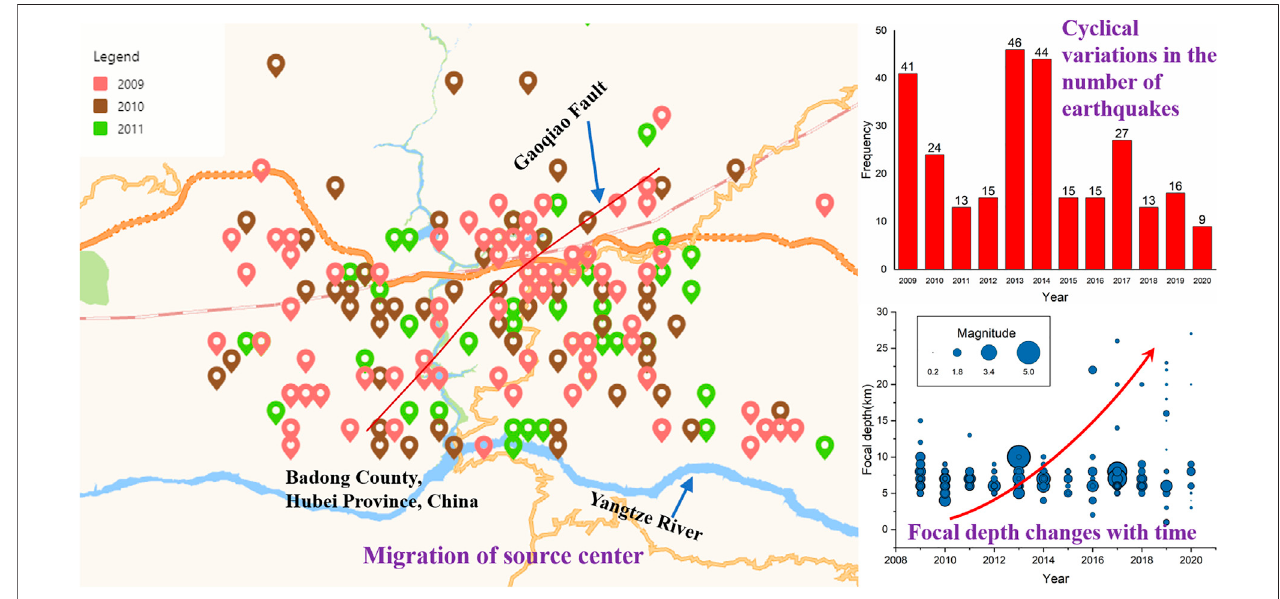
FIGURE 1 | Seismic law of Badong Reservoir in the Three Gorges Reservoir area.